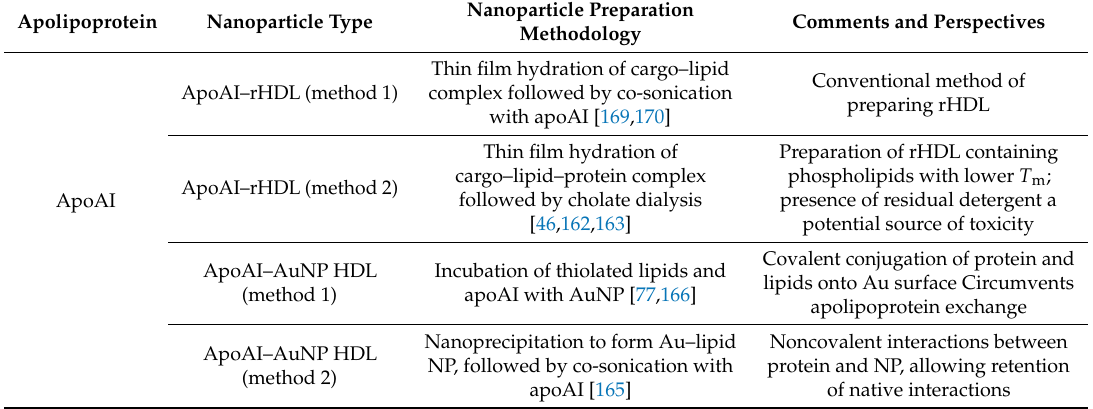
Table 2. Summary and perspectives of synthesis of apolipoprotein-based